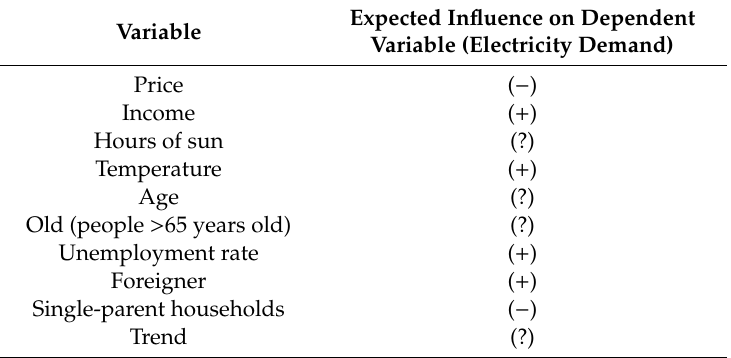
Table 1. Explanatory variables included in the model and their expected influence on electricity demand. Expected Influence on Variable